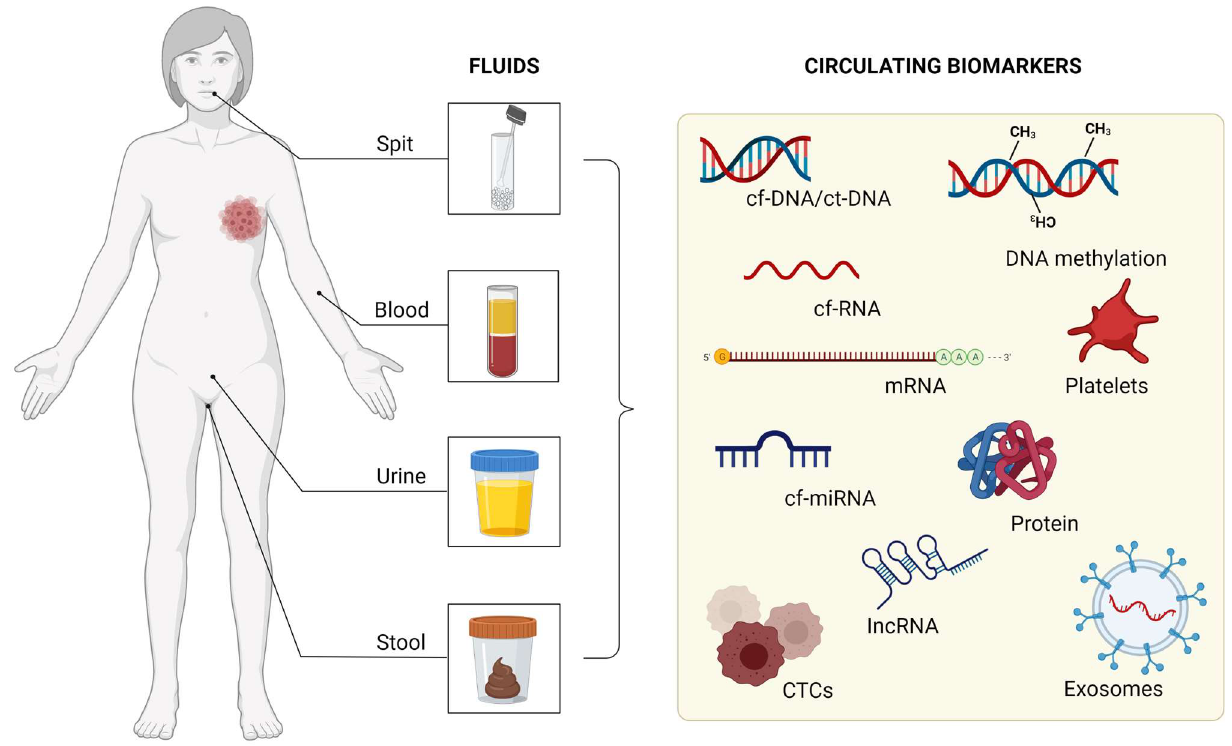
Figure 1. Fluids that can be used as circulating